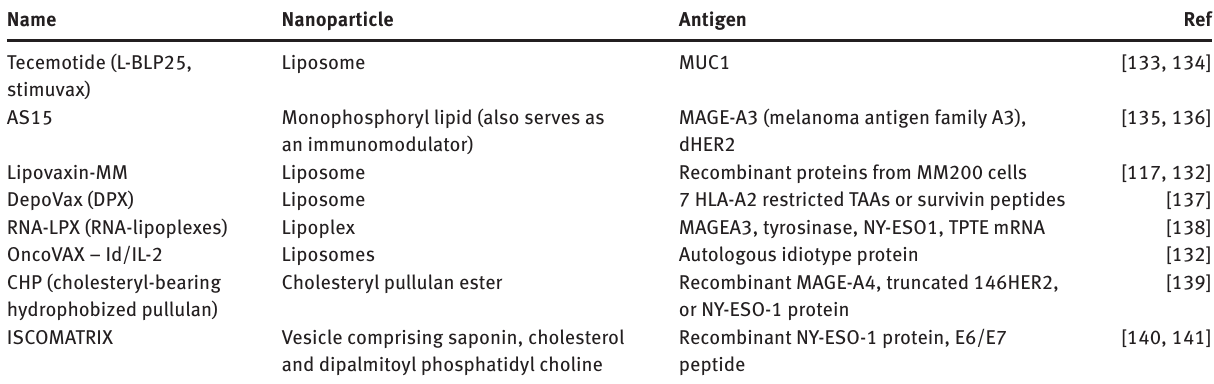
Table 4: Nanoparticle-mediated immunotherapies under clinical trials [132].